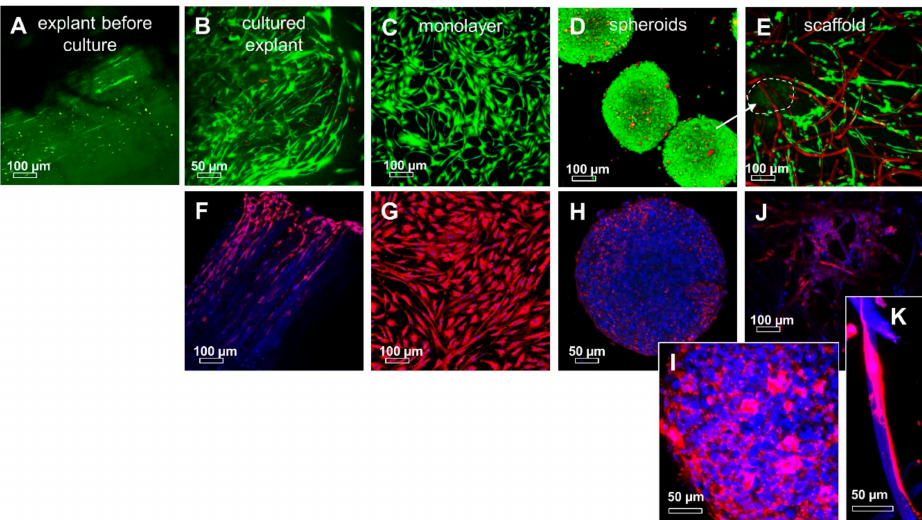
Figure 9. The vitality and α SMA immunoreactivity of ITB tissue and 2-D and 3-D cultured ITB fibroblasts. ( A ) Freshly prepared explant (before cultured); ( B ) explant after 109 days of culturing; ( C ) monolayer, P0; ( D ) mini spheroids consisting of 25.000 ITB cells after 3 days of spheroid formation; and ( E ) polyglycolic acid (PGA) scaffold colonized by ITB fibroblasts for 7 days. ITB cells emigrated from spheroids placed on the scaffold ( E ): the arrow and dashed line mark the position of the former spheroid) and spread on the fibers. Vital cells: green, dead cells or scaffold fibers: red. The α SMA immunoreactivity (red) is shown ( F ) in an explant after 109 days of culturing; ( G ) monolayer, P0; ( H ) mini spheroids consisting of 25.000 ITB cells after 2 days of spheroid formation (( I ) zoomed); ( J ) PGA scaffold colonized by ITB fibroblasts for 3 days; ( K ) zoomed inset. α SMA immunoreactive cells: red. Cell nuclei: blue. Some degrading fibers stain also blue. Scale bars: 100 µ m ( A – G , J) and 50 µ m ( H , I , K ).